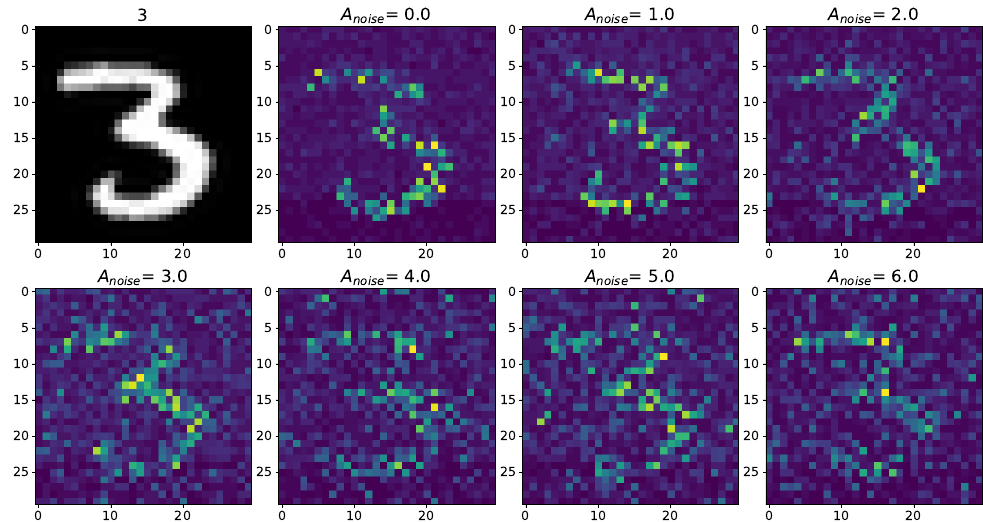
Figure A3. Changes in the spatial sweep of the spiking neural network during the representation of the supplied image from the Figure A1 when the amplitude, A noise , of the noise current, I noise , changes from 0 to 6 with modulation of neuronal activity by astrocytes.